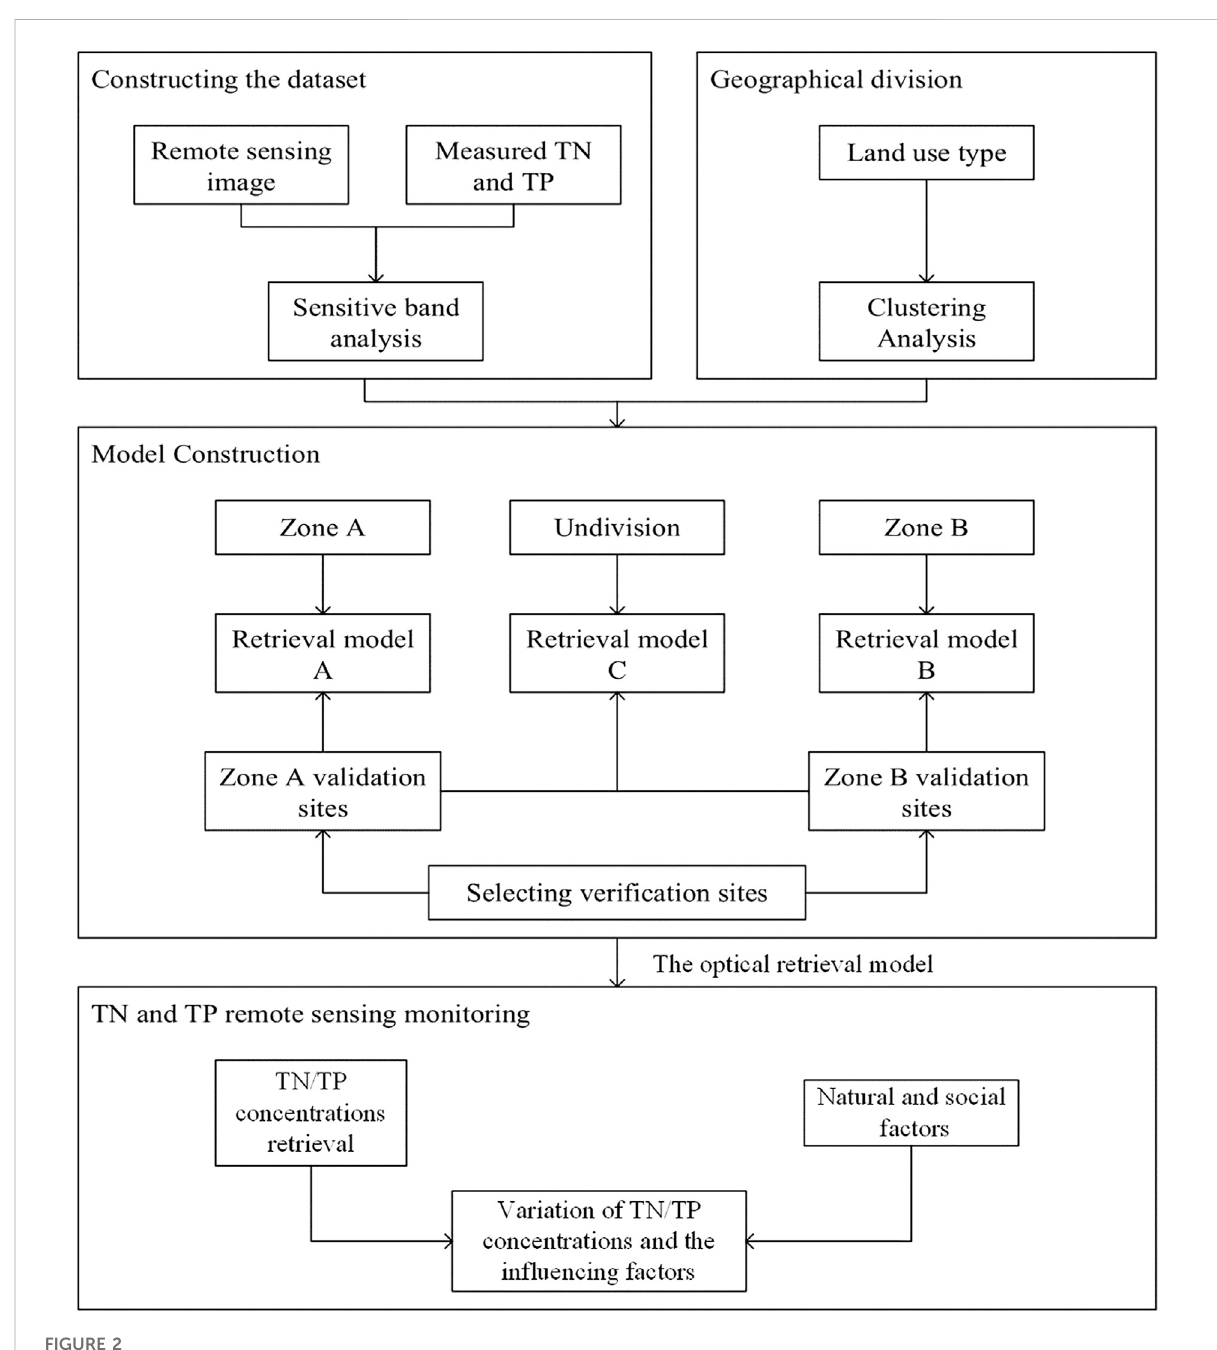
FIGURE 2 Flow chart of remote-sensing monitoring of the TN and TP